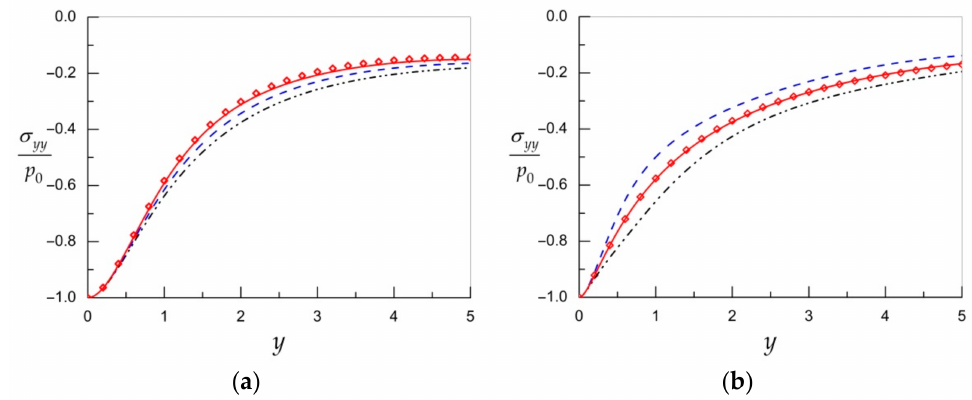
Figure 3. The dimensionless stress σ yy / p 0 at x = 0 and κ = 1 for material 1 ( a ) and material 2 ( b ) under different values of N in formula for resolvent kernel (22): N = 1 (dash-dot lines), N = 2 (dash lines), N = 3 (solid lines), and exact solutions (diamonds).